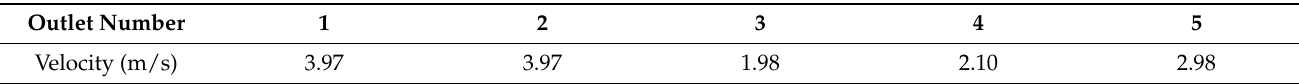
Table 2. The outlet air velocity of the centralized mode.